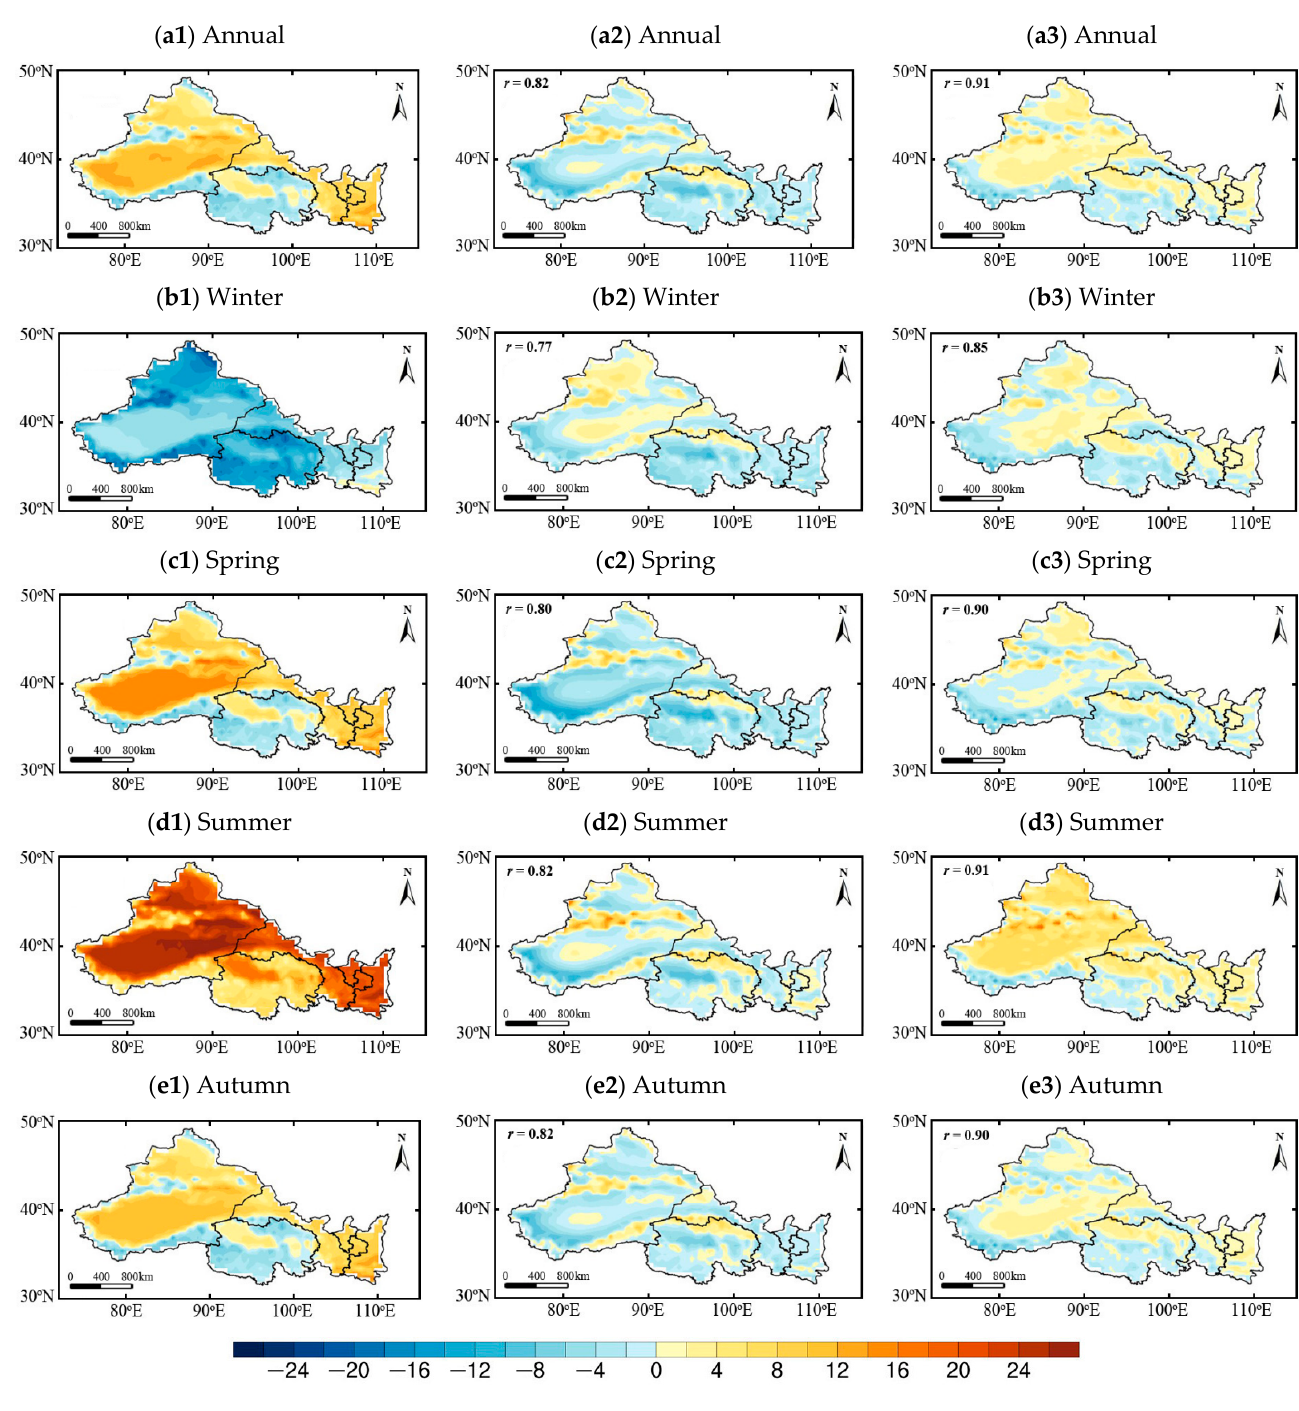
Figure 2. Distribution of daily mean temperature (unit: °C ) over Northwest China in different periods during 1961–2014: observations ( left ), and differences between the simulated values of the BCC-CSM2-MR model and the observations ( middle ), and the differences between simulated values of the BCC-CSM2-HR model and the observations ( right ). r in the upper left indicates the pattern correlation coefficient.